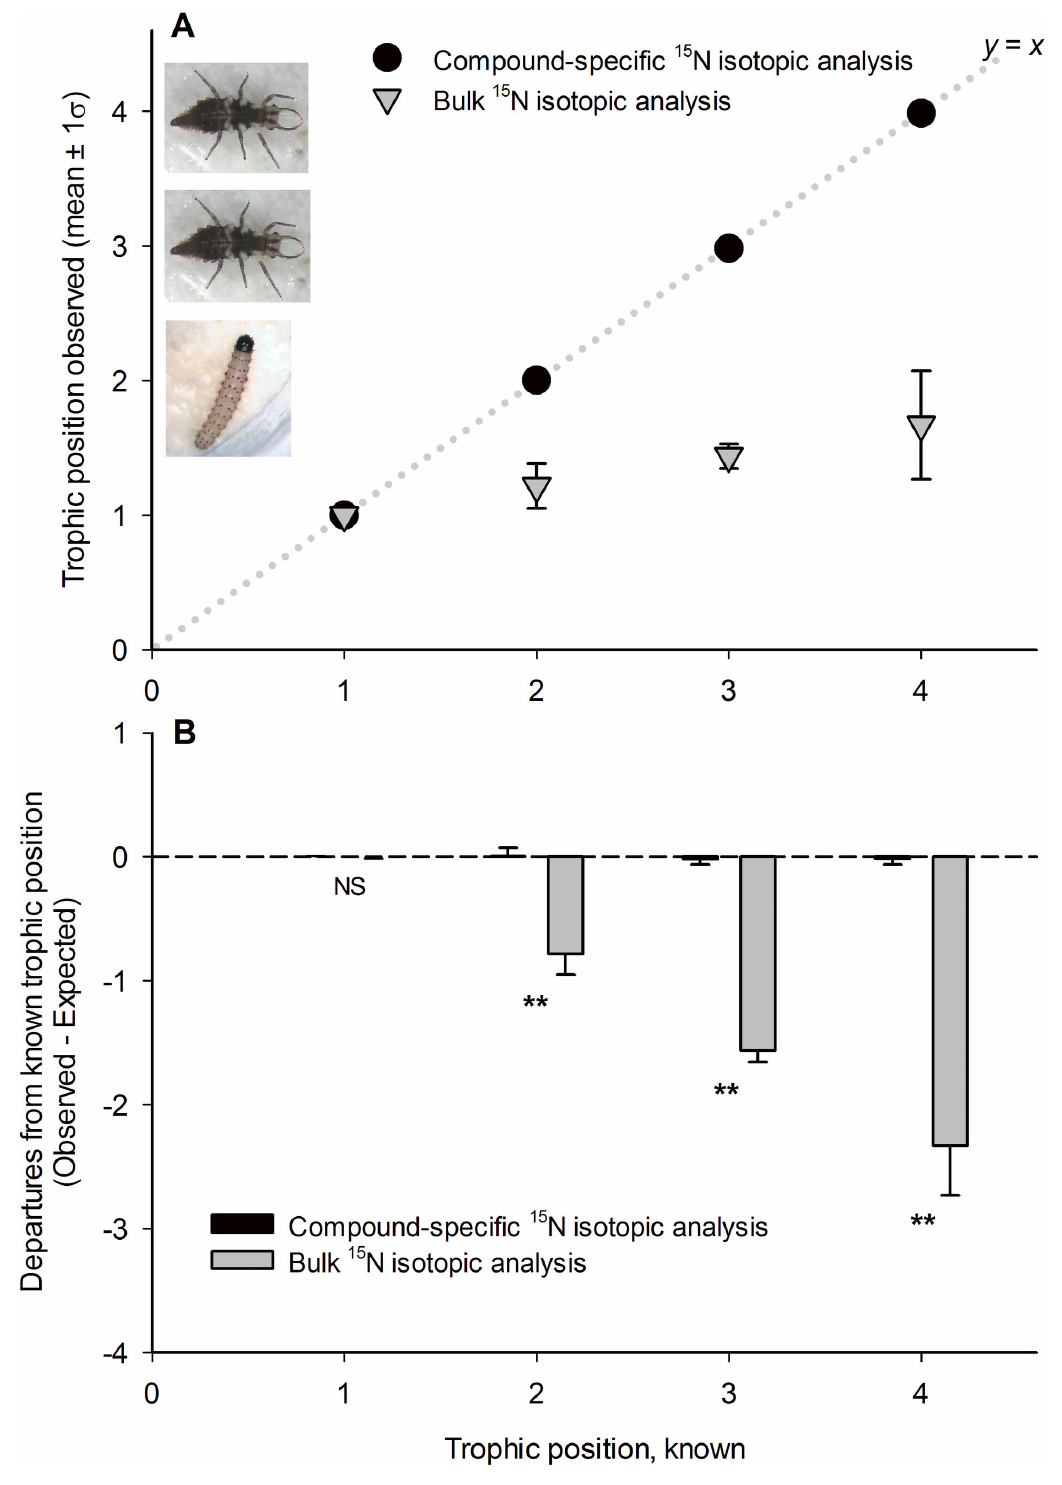
Figure 2. Trophic position estimates, controlled-feeding trials. Trophic position estimates (mean ± 1σ) from the controlled- feeding trials. A) Plots of observed trophic positions vs. their corresponding known trophic positions. Black circles indicate TP estimates, and gray triangles indicate TP estimates. The dotted line ( y = x ) represents perfect agreement between observed and bulk known trophic positions. B) Degree of departure between the observed and known trophic positions (mean ± 1σ). doi: 10.1371/journal.pone.0076152.g002 PLOS ONE |